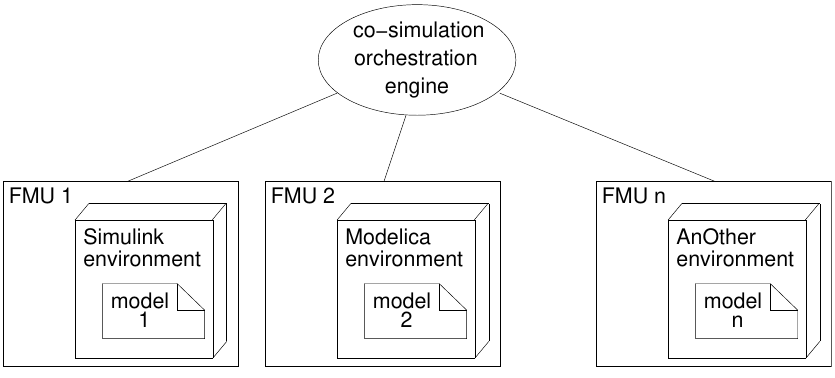
Figure 1. FMI co-simulation